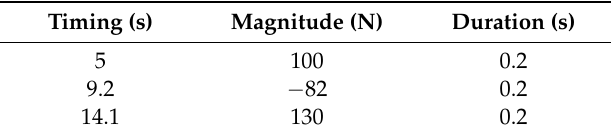
Table 6. Impact forces applied to the body.